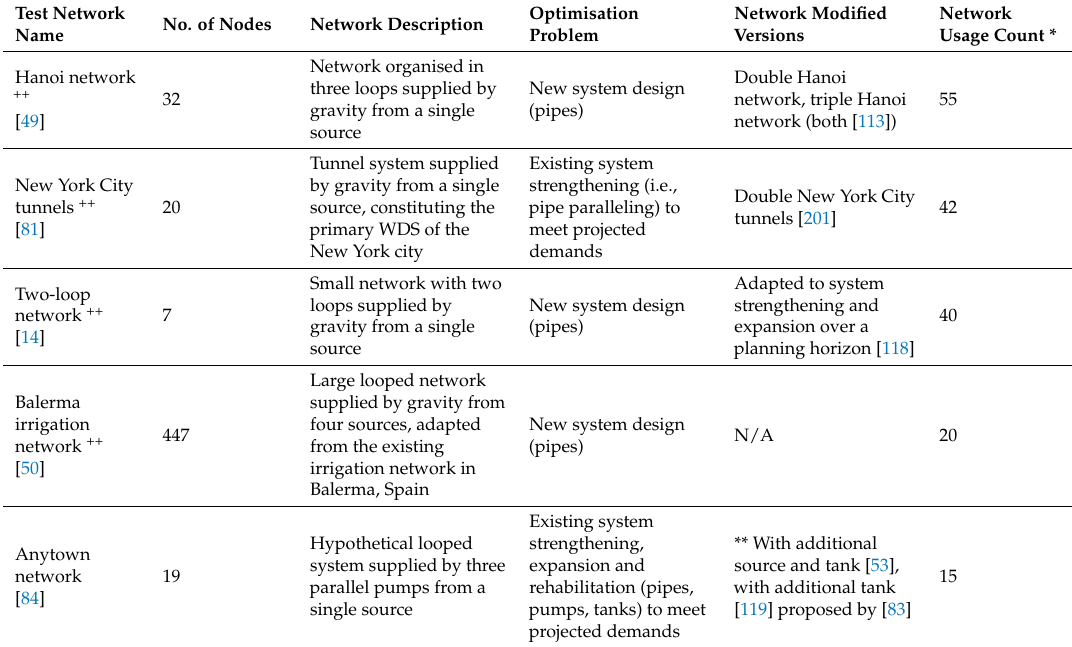
Table 4. Frequently used test